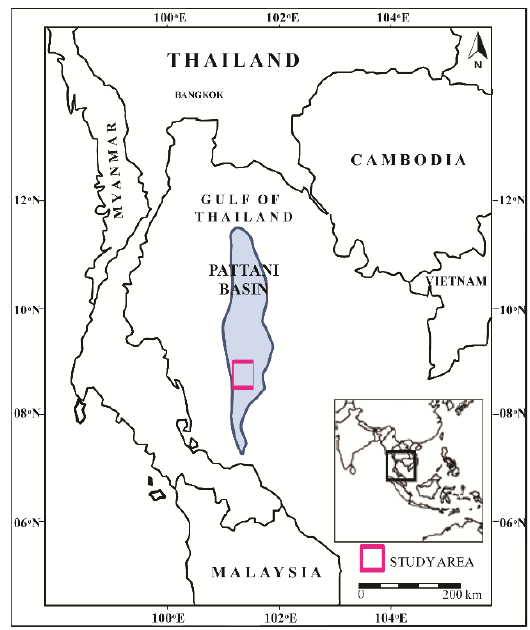
Figure 1: Location map of the study area